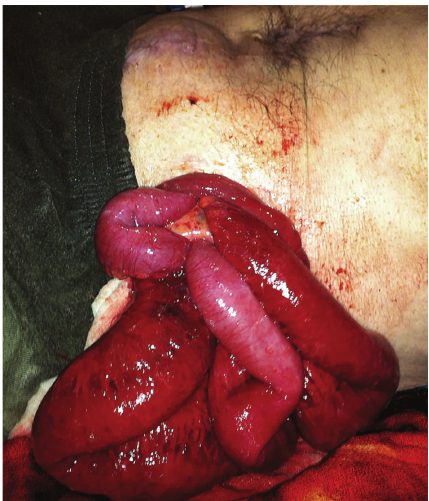
Figure 1: The view of eviscerated small bowels through the colostomy in the emergency department.